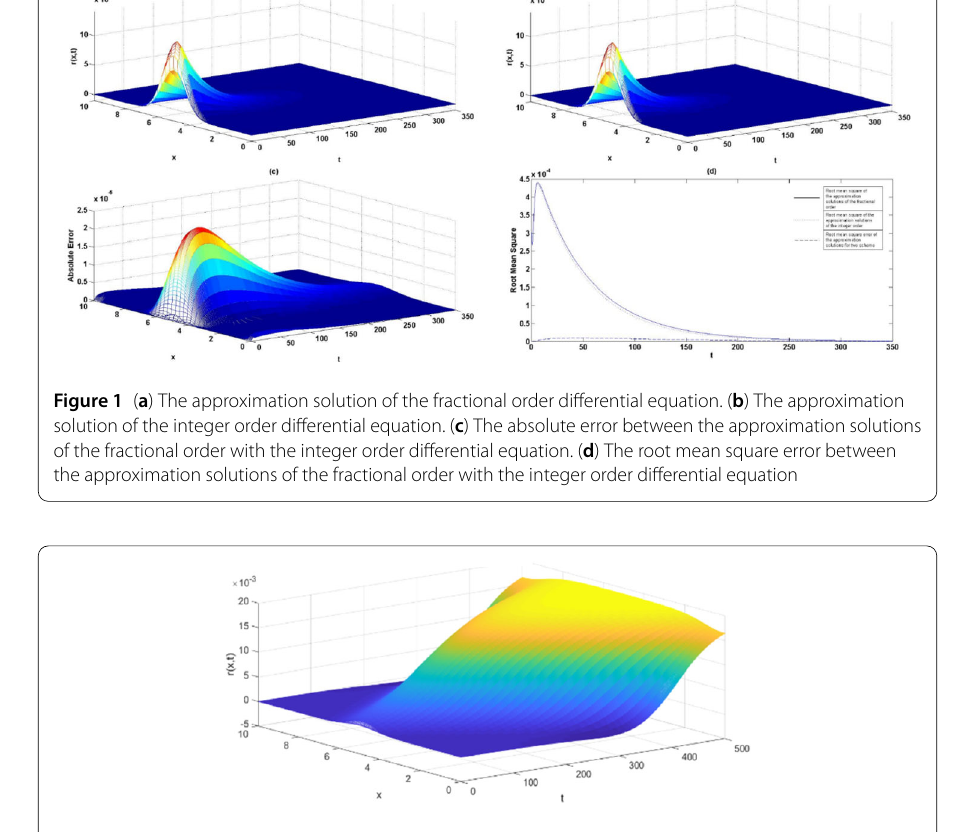
Figure 2 The approximation solution of the fractional order differential